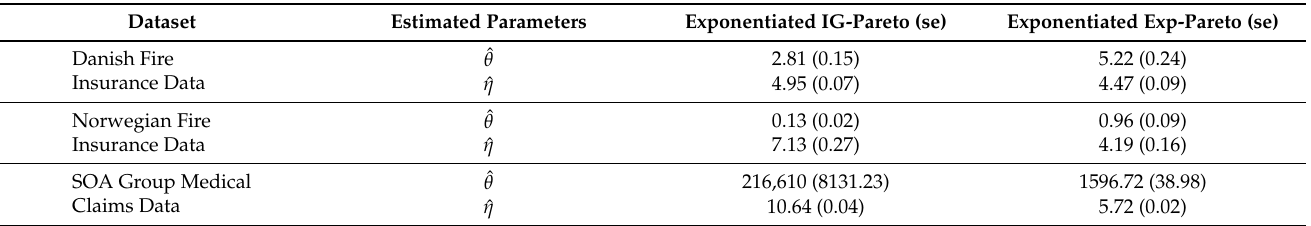
Table 8. The parameter estimates and estimated standard error of the exponentiated-composite models, when fitted to the three